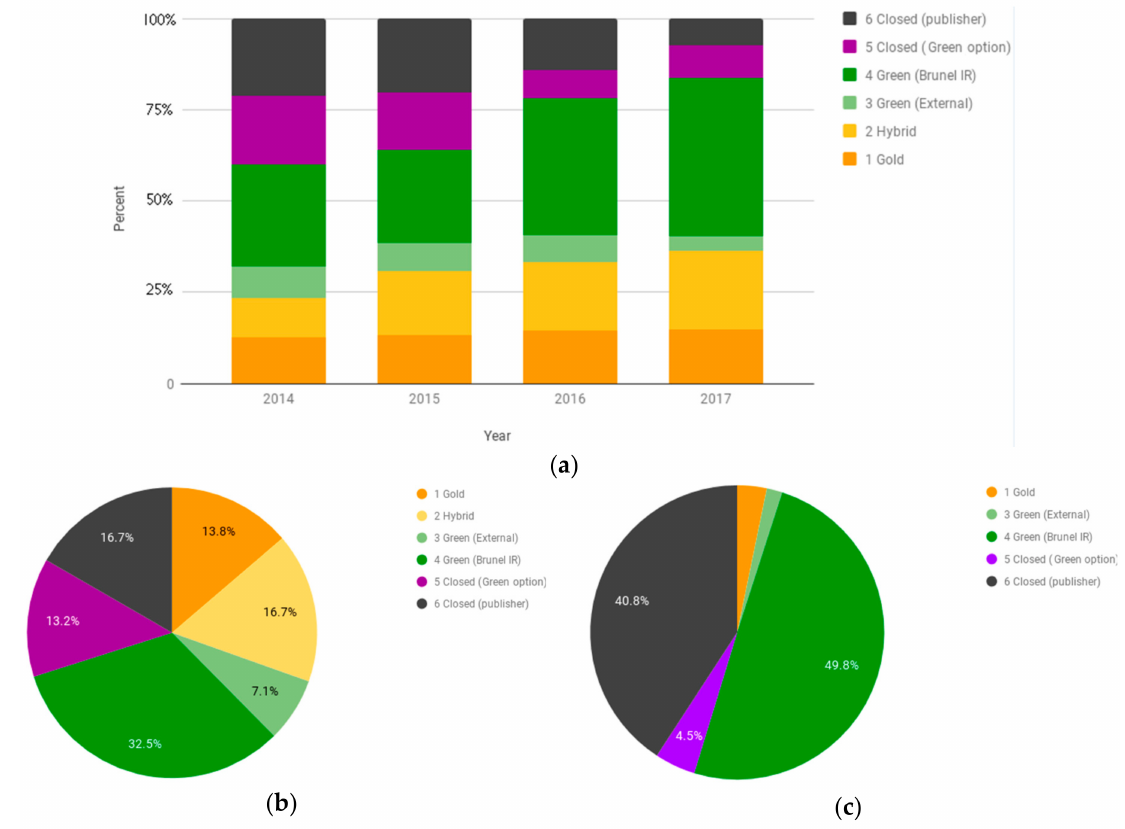
Figure 3. The enhanced publication dataset (“Best available” classification) 2014–2017, ( a ) Brunel OA dissemination by year (percentages on publication); ( b ) Brunel OA dissemination 2014–2017 (percentages on publication); ( c ) Brunel OA dissemination 2014–2017 (percentages on